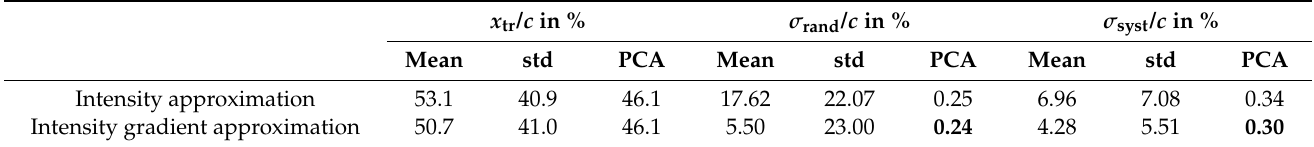
Table 2. Located flow transition position x tr and corresponding random and systematic error σ rand and σ syst by means of both localizations methods for each image processing methods’ resulting flow visualization in the DU96W180 test case 1 at a Re = 2 × 10 6 . Temporal mean value (mean), temporal standard deviation (std) and PCA. All values are normalized to the chord length c .